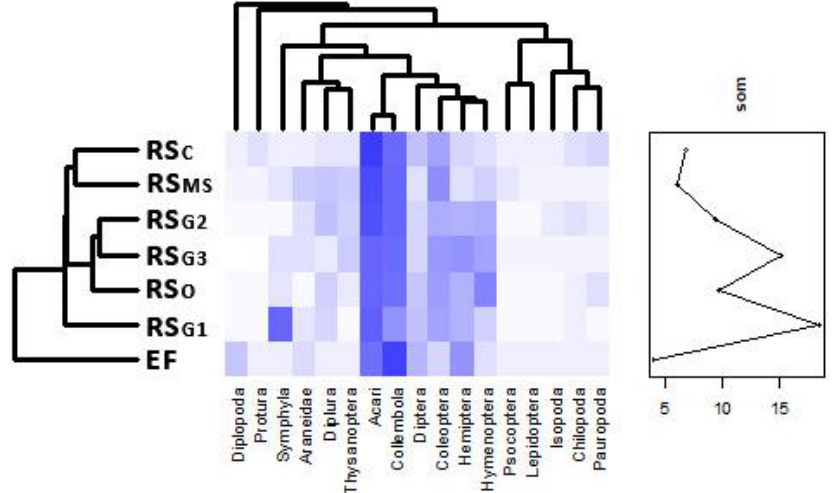
Figure 5. Heat map of the community composition, with colour intensities proportional to taxa abundance, and UPGMA (unweighted pair-group method using arithmetic averages) clustering of a matrix of Bray–Curtis distance among sites (on the left side) and of the taxa that occur more often together (on the top side); on the right side, the SOM values are displayed.